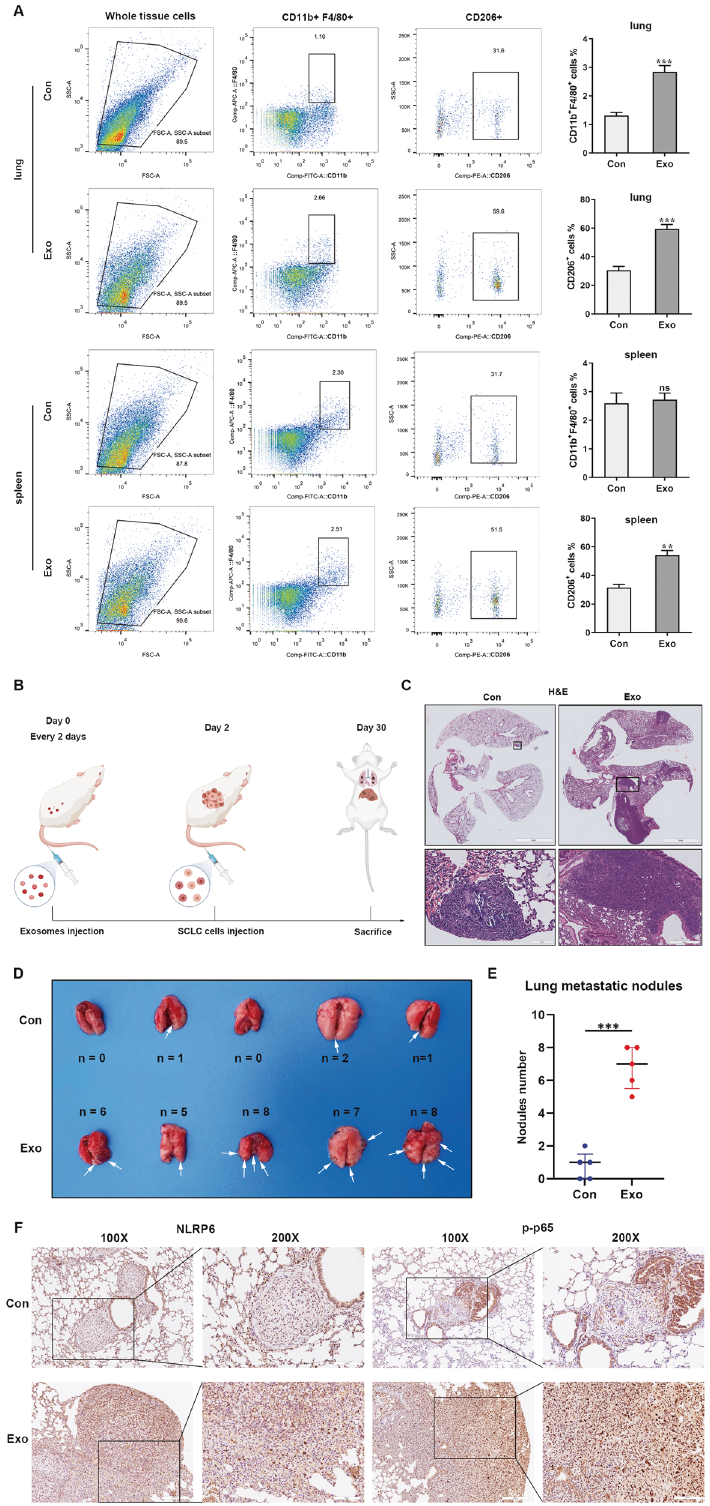
Fig. 6 SCLC-derived exosomes promote metastasis in vivo. A Flow cytometry analysis showing that SCLC-derived exosomes promote M2 macrophages switch in vivo ( n = 5). Con, mice treated with PBS. Exo, mice treated with exosomes. B A schematic representation of the in vivo study design and experimental work fl ow. C SCLC-derived exosomes increased lung SCLC tumor number in vivo. White arrows point to the SCLC tumor site ( n = 5). Con, SCLC tail vein-injected mouse models treated with PBS. Exo, SCLC tail vein-injected mouse models treated with exosomes. D Representative images of H&E staining in SCLC tumor site in different groups. E Statistical analysis of the number of visible lung tumors in different groups ( n = 5). F Representative IHC images of NLRP6 and p-p65 in SCLC tumor site in different groups ( n = 5). Bar graphs show the means ± SEM; ** P < 0.01, *** P < 0.001. SCLC small cell lung cancer, H&E hematoxylin and eosin, IHC immunohistochemistry, SEM standard error of mean. Cell Death and Disease (2022)